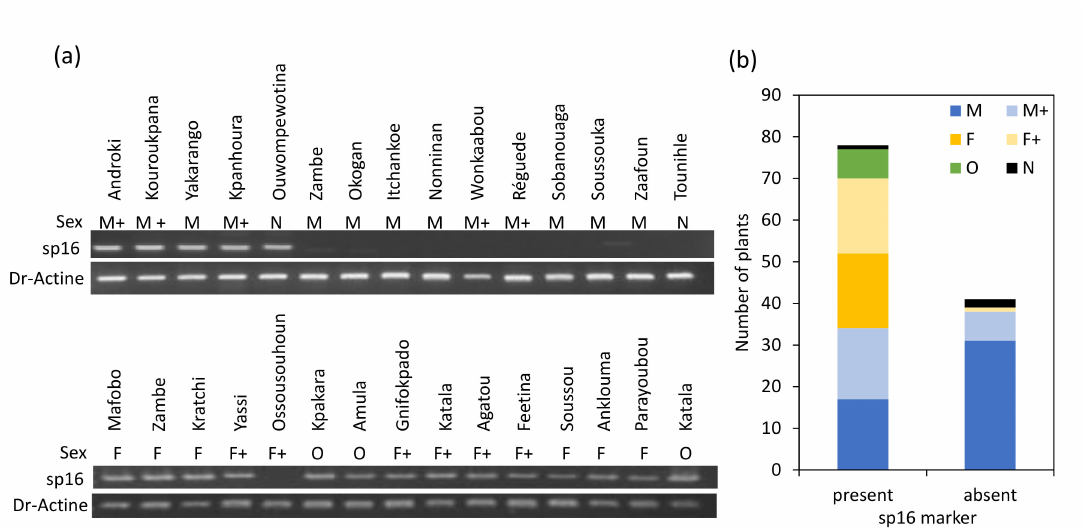
Figure 2. Analysis of the genetic marker sp16 in cultivars of D. rotundata from Benin. ( a ) PCR amplification for sp16 and Dr-Actine in a few cultivars. Dr-Actine is used as a positive control. ( b ) Distribution of individuals according to their sex identity and the presence or absence of the sp 16 marker. M, stable male; M + , unstable male; F, stable female; F + , unstable female; O,